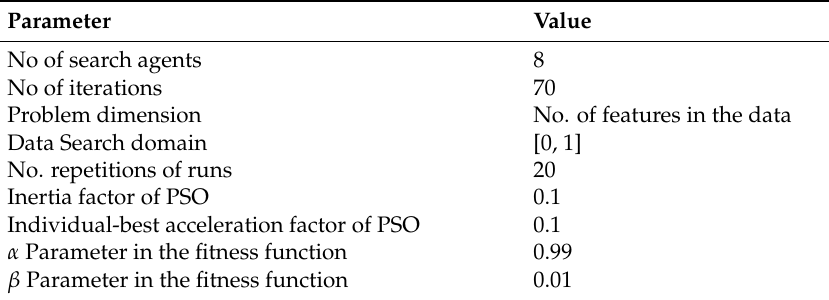
Table 1. Parameter